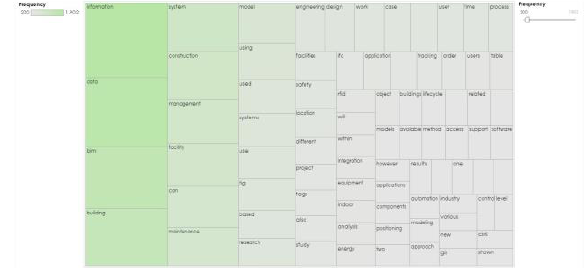
Figure 3: Frequency of occurrence for commonly occurring words (Tree map View)